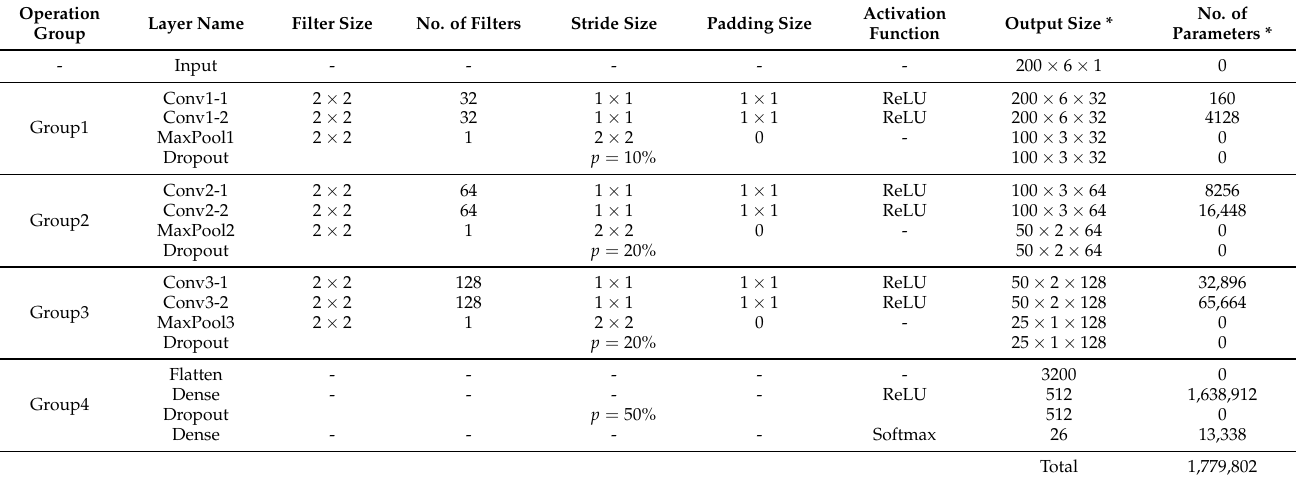
Table 2. Network architecture of the 2D-CNN model for air-writing recognition based on smart-band dataset. Operation